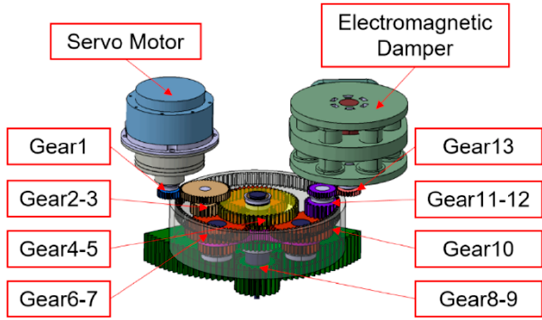
Figure 6. Specific structure of electric nose wheel steering system.